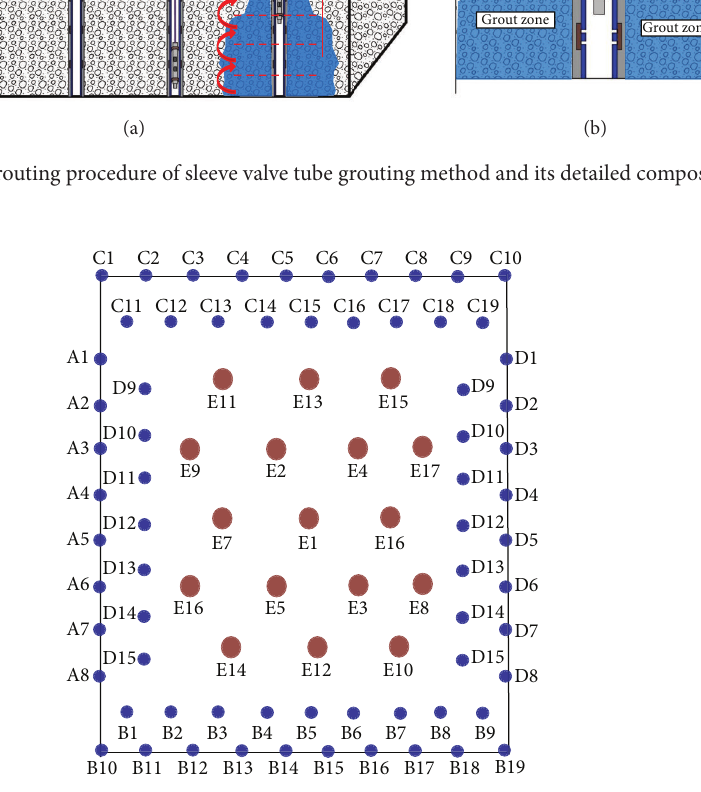
Figure 9: Distribution of 2 groups of